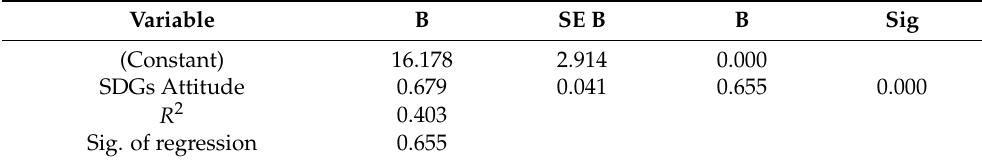
Table 12. Summary of regression analysis for SDGs attitude predicting SDGs motivation.